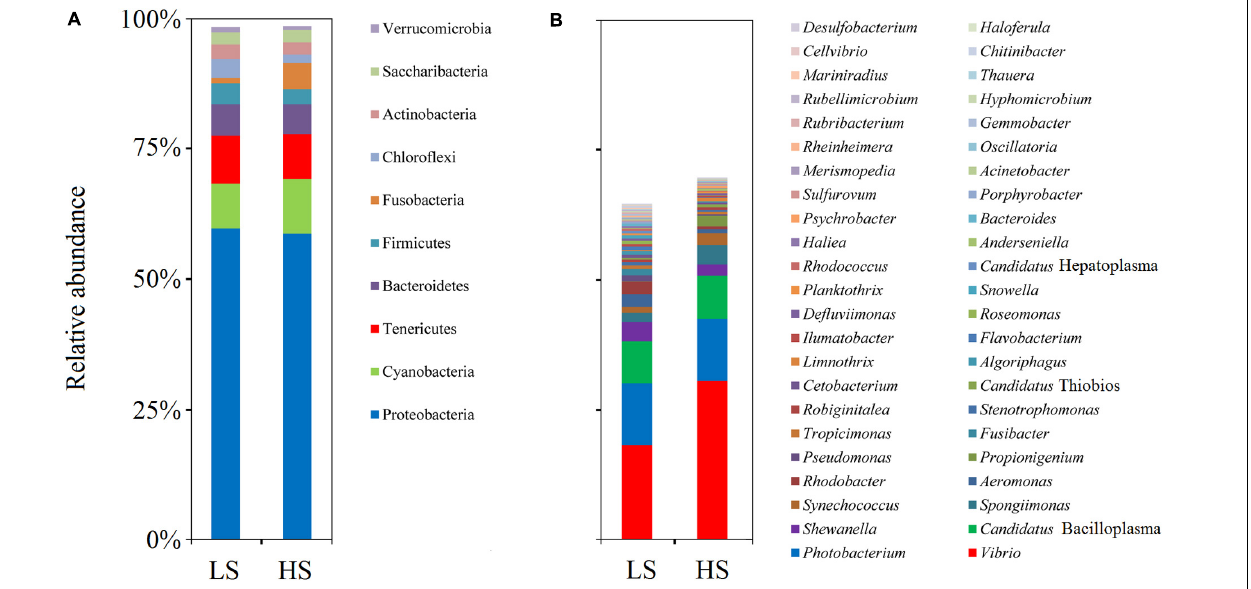
FIGURE 3 | Bacterial profiles of shrimp intestine in the LS and HS groups. Relative abundance of phyla (A) and genera (B) in the LS and HS groups. Proteobacteria, Cyanobacteria, Tenericutes, Bacteroidetes, Firmicutes, Fusobacteria, Chloroflexi, Actinobacteria, Saccharibacteria, and Verrucomicrobia were the 10 most abundant phyla in shrimp intestine, while Vibrio , Photobacterium , Candidatus Bacilloplasma, Shewanella , Spongiimonas , Synechococcus , Aeromonas , Rhodobacter , Propionigenium , and Pseudomonas were the 10 most abundant genera, with the relative abundances of these genera varying between the two